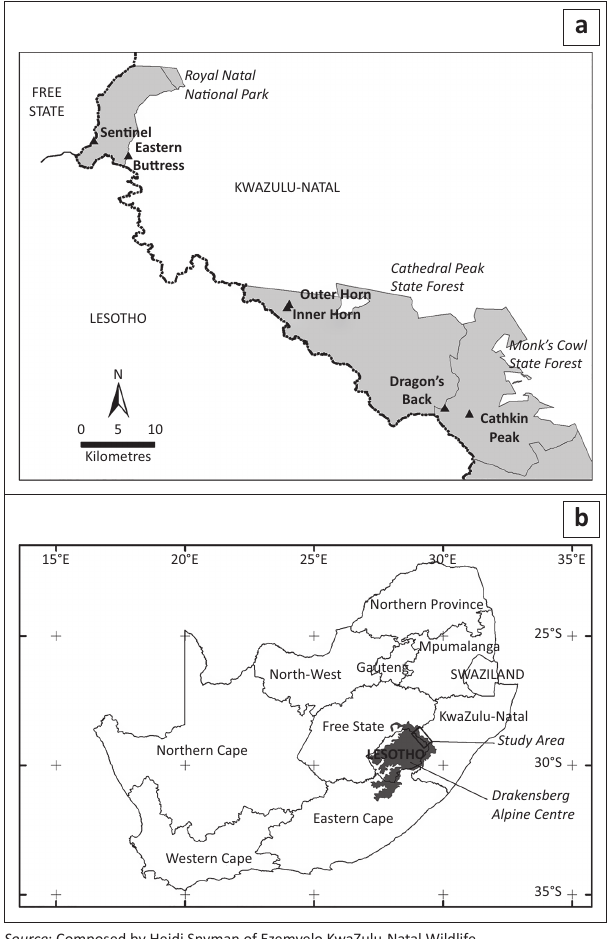
FIGURE 1: Maps of study sites: (a) study area with KwaZulu-Natal uKhahlamba- Drakensberg Park (shaded) and (b) South Africa indicating Drakensberg Alpine